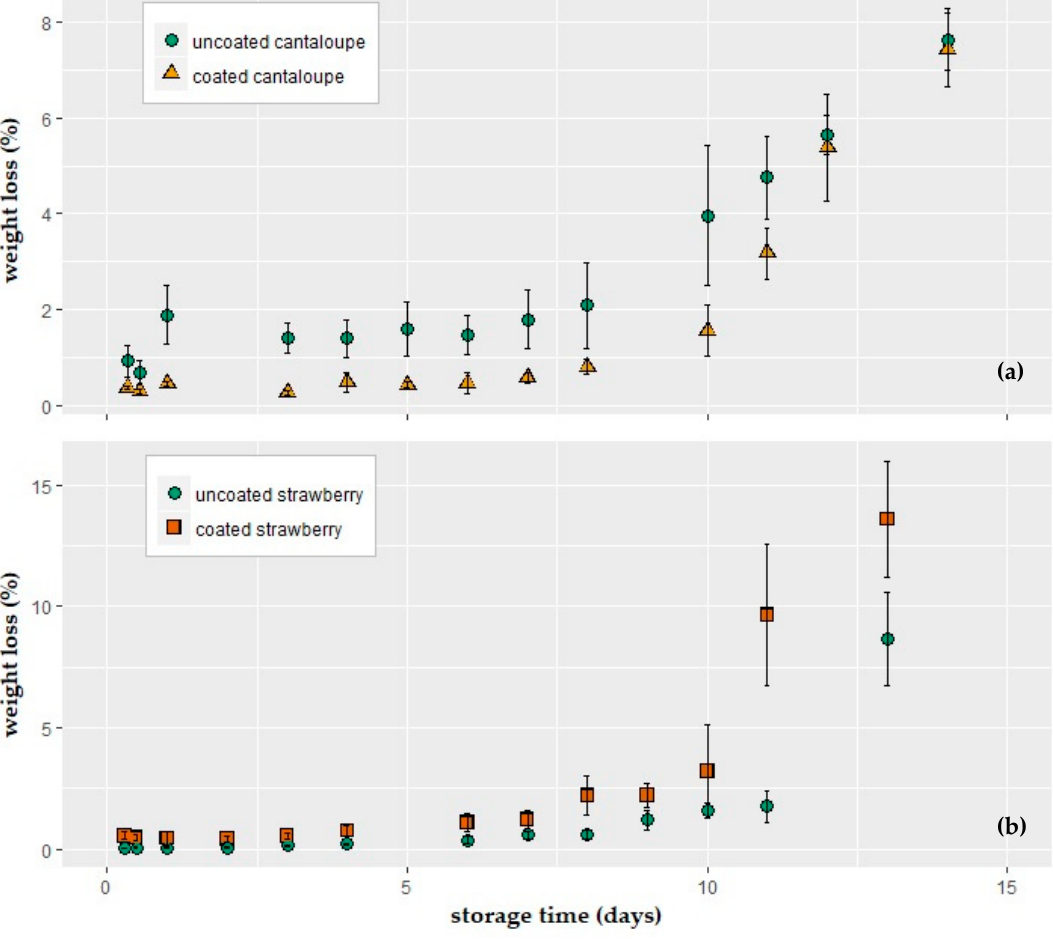
Figure 3. Weight loss of ( a ) fresh-cut cantaloupe; ( b ) strawberry fruits coated with an alginate-based solution (1.25% alginate + 2 glycerol + 0.2% sunflower oil + 1% span 80 + 0.2% tween 80 and 2% calcium lactate (crosslinking agent)) during storage at 10 °C and 90% relative humidity (RH).